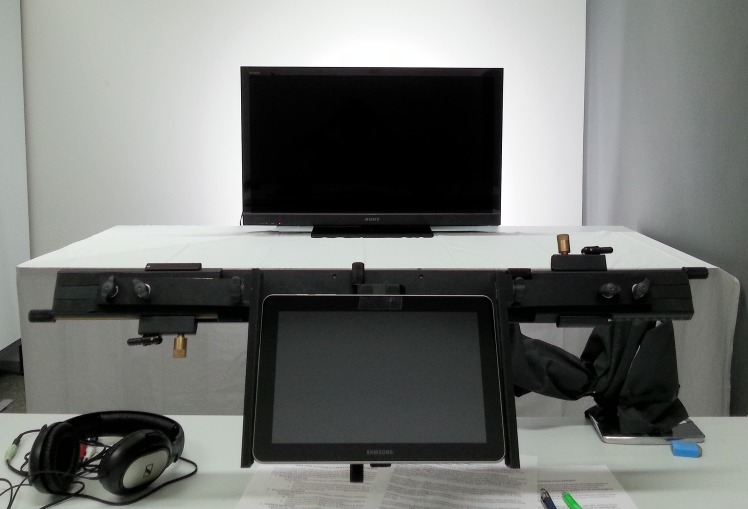
Snapshot of the experimental setup from a participant’s first-person view.